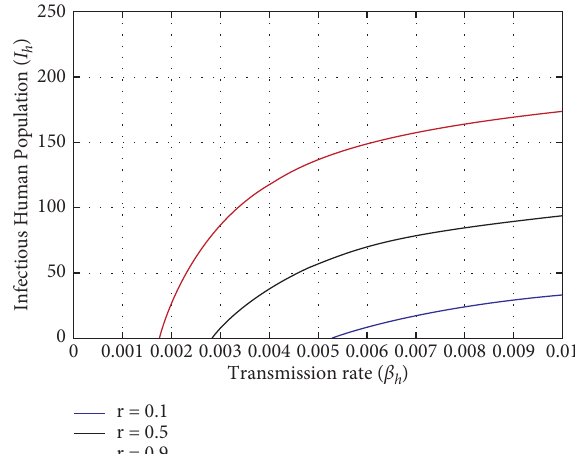
Figure 15: Bifurcation diagram without fumigation with different values of r when 0 < k < 1.